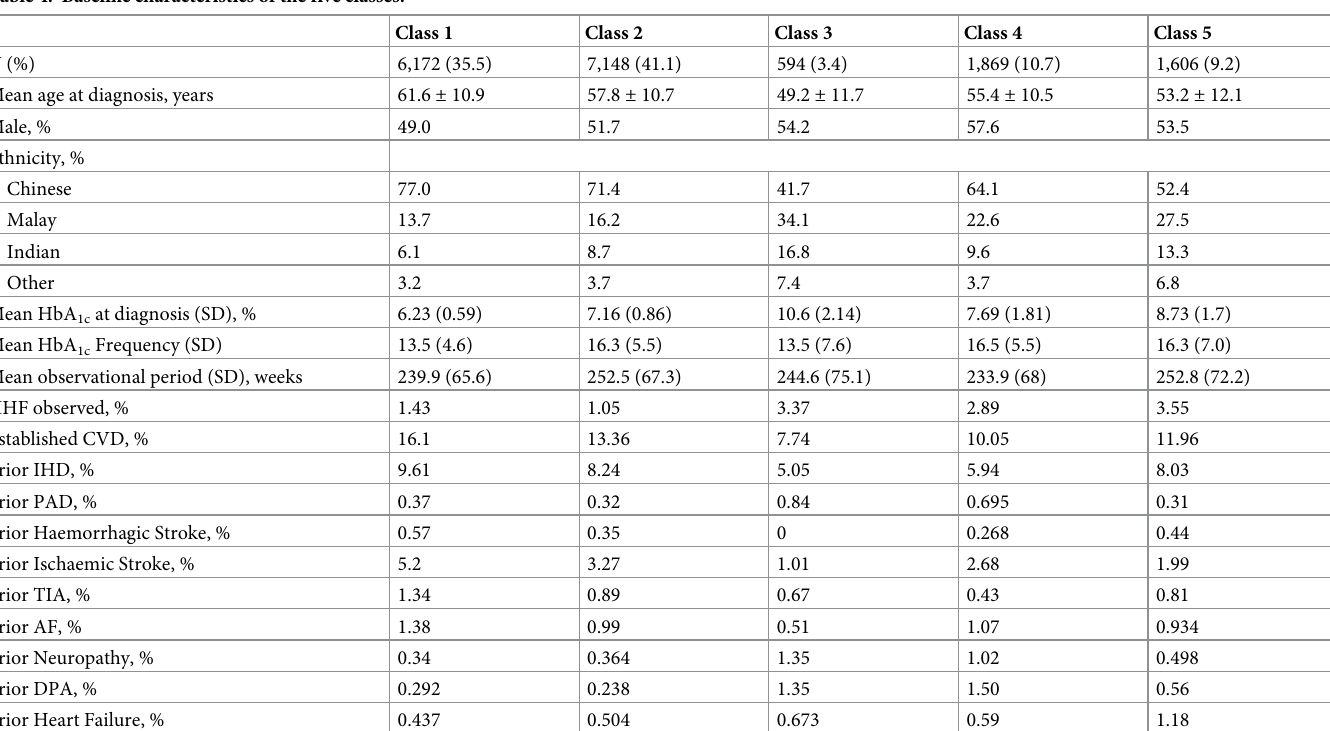
Table 4. Baseline characteristics of the five